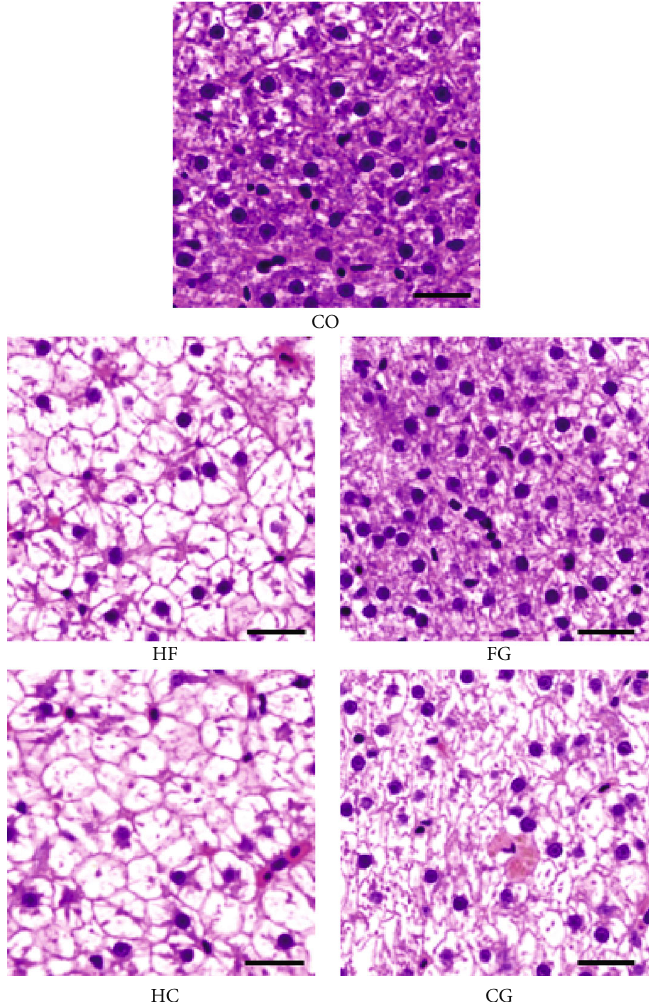
Figure 1: Histological characteristics of the liver of common carp fed di ff erent experimental diets (H&E stain). Bar: 20 μ